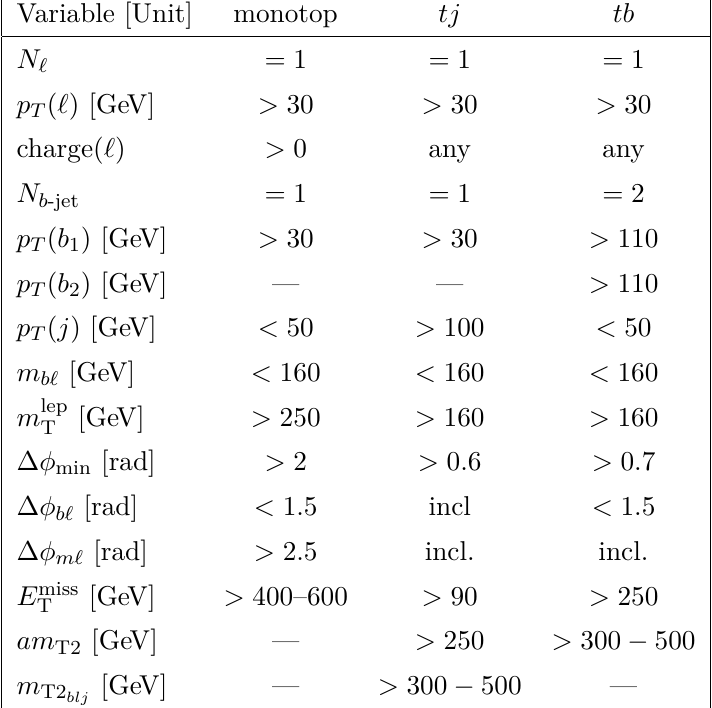
Table 2 . Summary of the selection criteria for the three proposed single-top analyses. The cuts on E miss and m respectively for the monotop and tj analyses are optimised separately for each T2 blj T value of m within the range given in the table. The variable p φ the hardest jet not tagged as a b -jet.